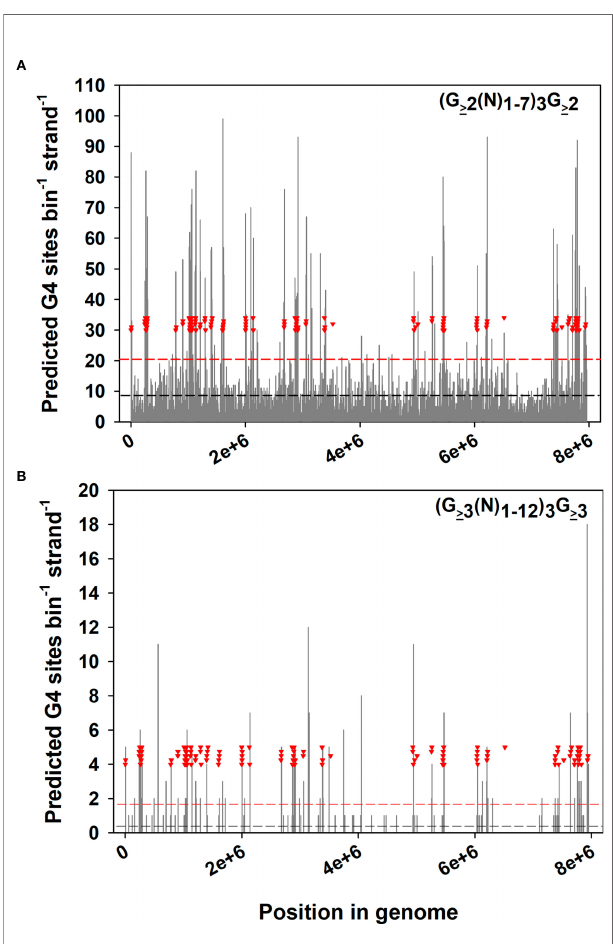
FIGURE 1 | Distribution of predicted G-quadruplex sequences relative to ves genes in the B. bovis genome. The B. bovis C9.1 genome (Jackson et al., 2014) was concatenated and surveyed for G4 motifs, using (A) the low stringency motif (G ≥ 2 (N)1-7) 3 G ≥ 2 or (B) a high-stringency motif (G ≥ 3 (N) 1-12 ) 3 G ≥ 3 . These results were plotted as histograms of G4 density per 8 Kbp genome segments. Inverted red triangles indicate the “ left ” -most ends of ves coding sequences. The dashed horizontal lines represent the mean G4 density across the genome (black), or +2 s.d.